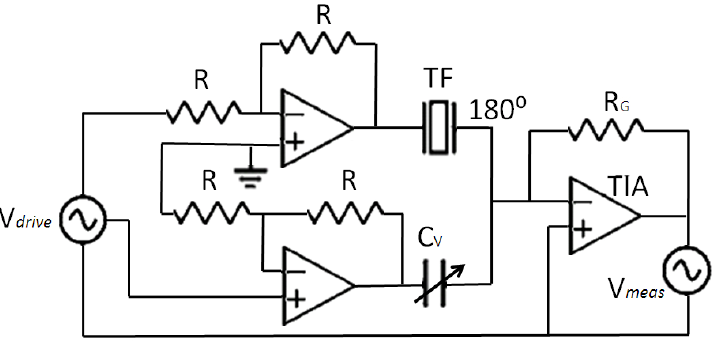
Figure 4. Implemented circuit for parasitic capacitor